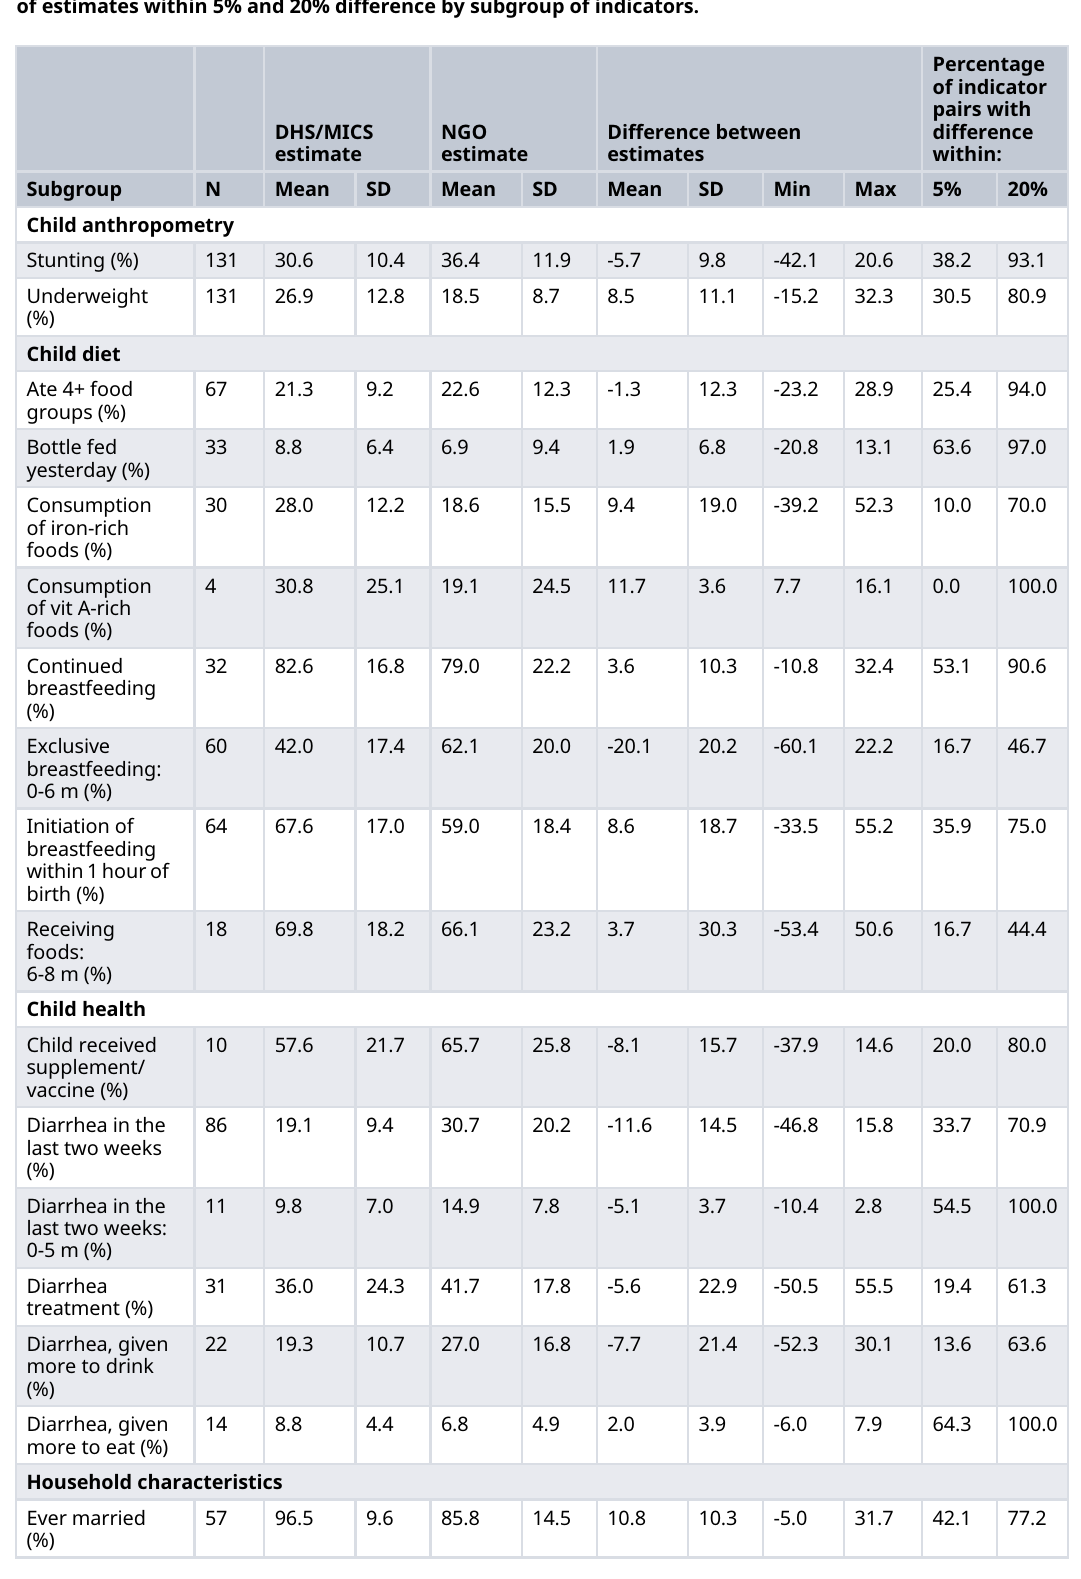
Table 6.DHS/MICS and NGOestimates, difference betweenestimates (DHS/MICSminus NGO)and proportion of estimates within 5% and 20% difference by subgroup of indicators.